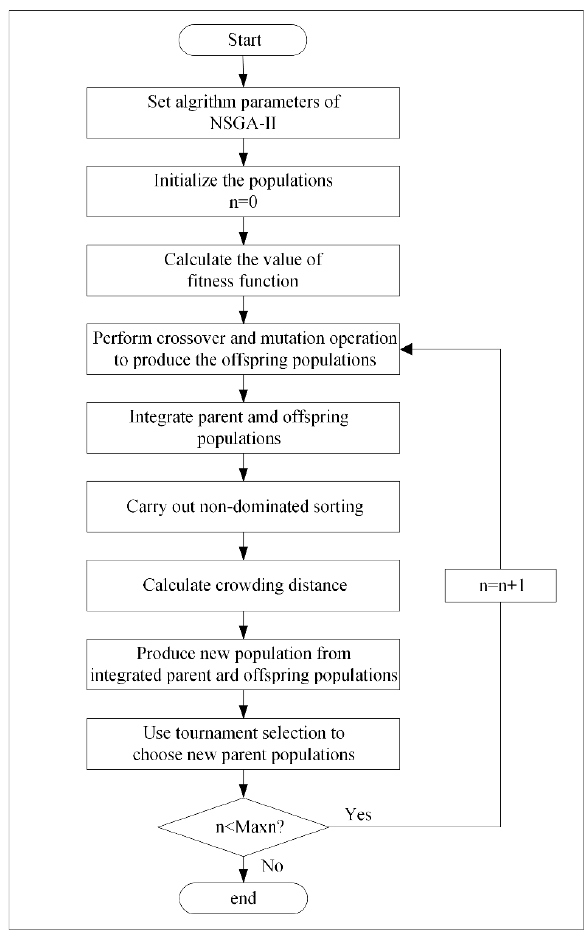
Figure 3. Flow chart of